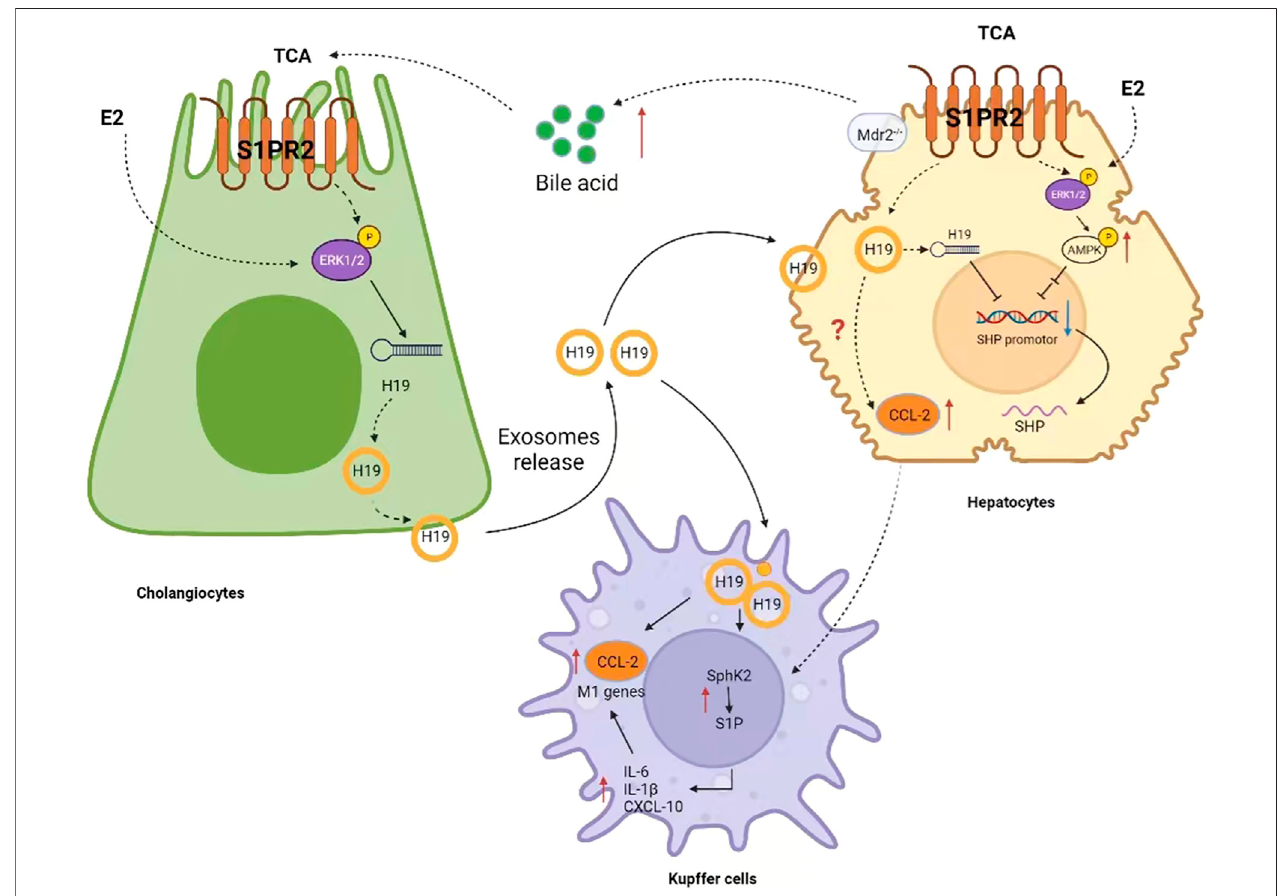
FIGURE 3 | Molecular mechanism of lncRNAH19 promoting cholestasis and activating